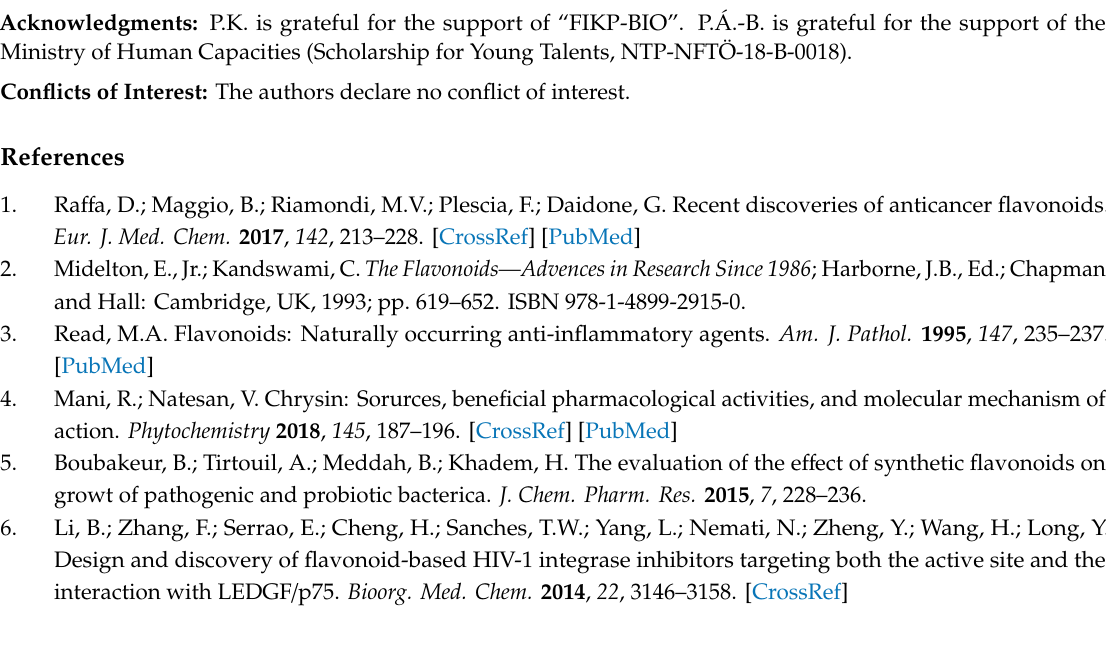
Table S1: Energy values obtained for the computation of the 1 → 2 transformation and the related dimerization. The E, ZPE, U, H and G values were computed using the B3LYP / 6-31 (d,p) method and are given in